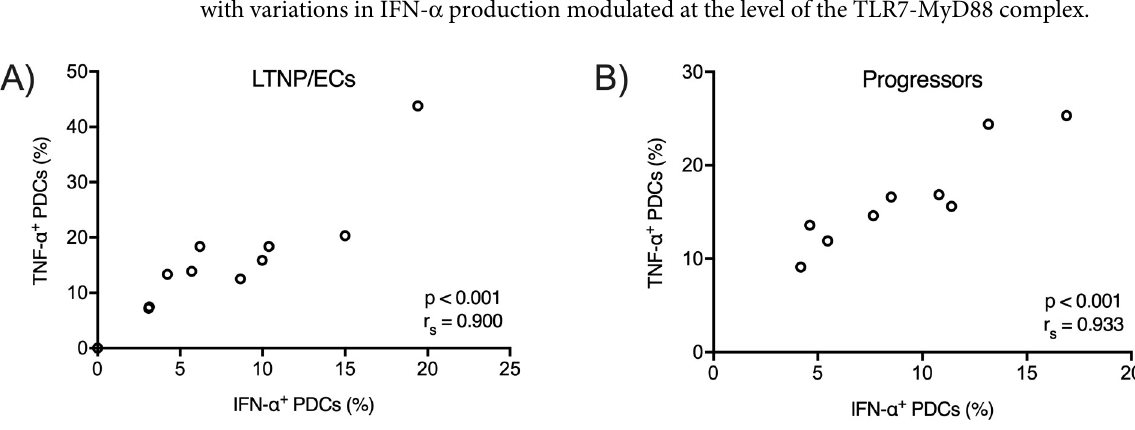
Fig 5. IFN- α and TNF- α production correlates in PDCs following RNA40-DOTAP stimulation that bypassed CD4-mediated entry. PDC TLR7 receptors were stimulated by RNA40-DOTAP in order to bypass viral binding, entry, and uncoating. P and r s values were calculated by the Spearman rank